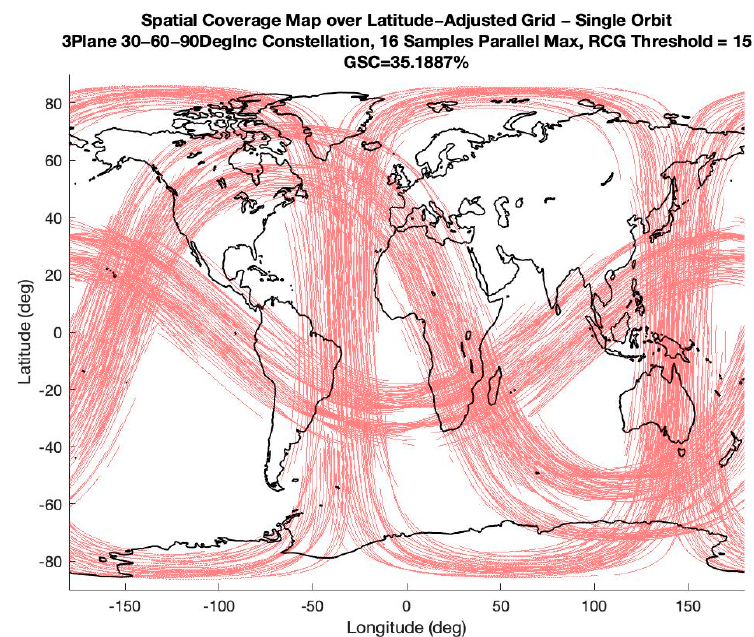
Figure 3. Single-Orbit Spatial Coverage for 3-Plane 30°-60°-90° constellation at 800 km, 16 parallel measurements per sampling, and operating with an RCG Threshold of 15. The inclination distribution provides greater coverage at the various orbit peaks, allowing for a greater GSC than the 30°-30°-30° constellation.